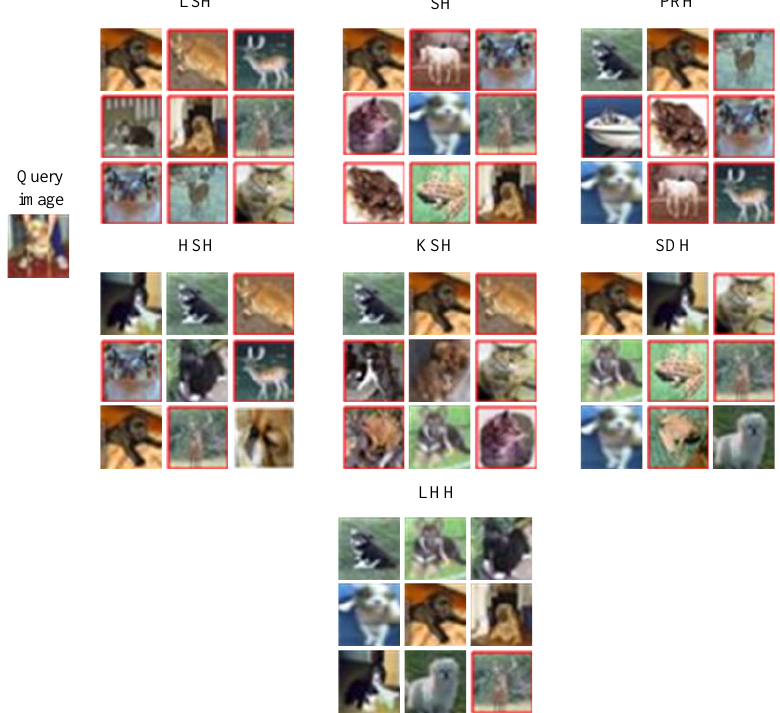
Figure 5. Visualized retrieval results on the CIFAR10 by six hashing methods with hash codes of 32 bits.